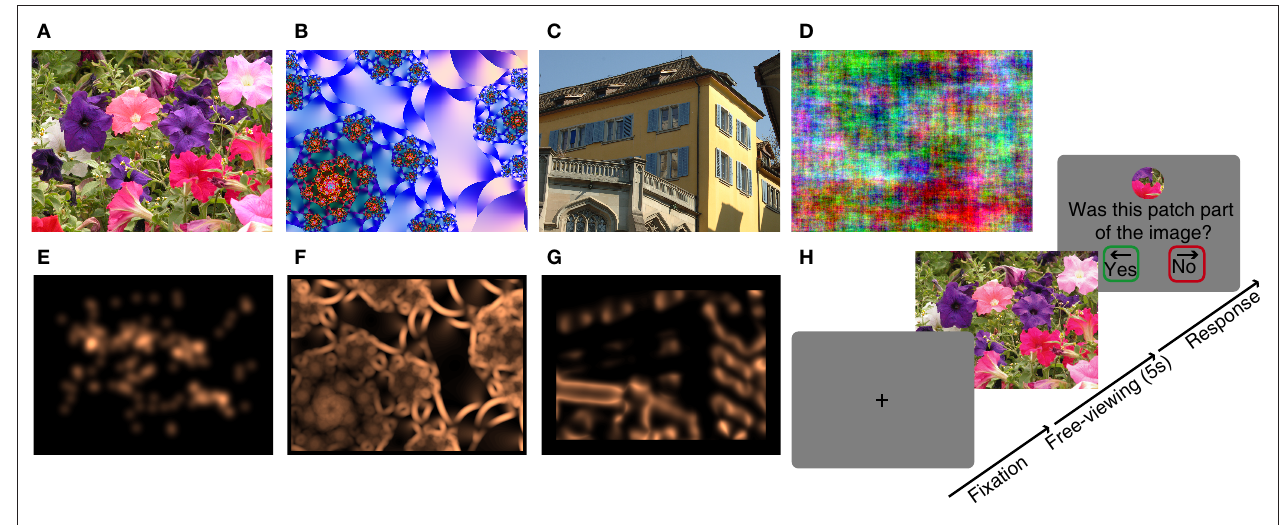
Figure 1 | Stimuli and methods. (A–D) Representative examples from the naturals , fractals , manmades , and the pinks categories, respectively. (e) The fixation map of the above presented naturals image generated by taking young adult fixations. (F) Luminance contrast map of the above presented fractals image. (g) The intrinsic dimensionality map of the above presented manmades image. Please note that the absolute values of different features or fixation probabilities do not matter in the information theoretical analyses employed in